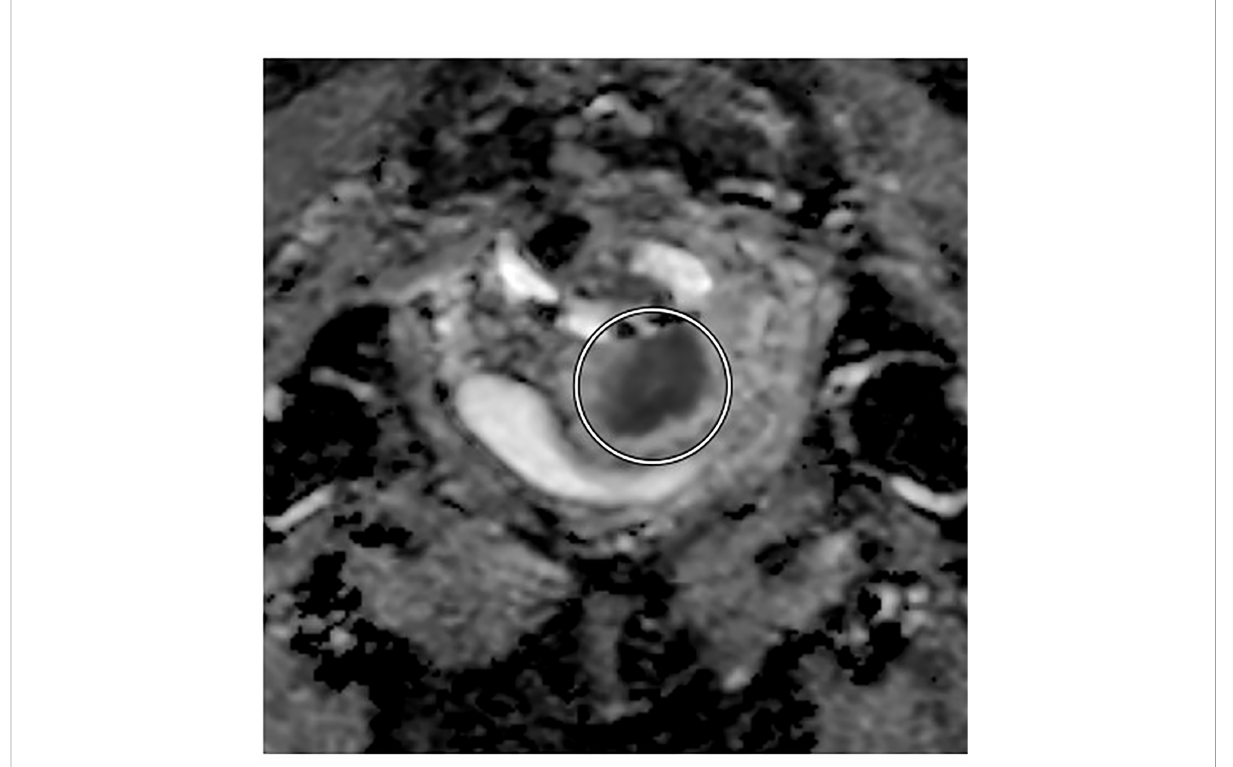
FIGURE 3 Axial diffusion-weighted MRI showing pre-treatment decreased tumor signal intensity in a patient with FIGO IIIC1, pathologic T2 squamous carcinoma of the